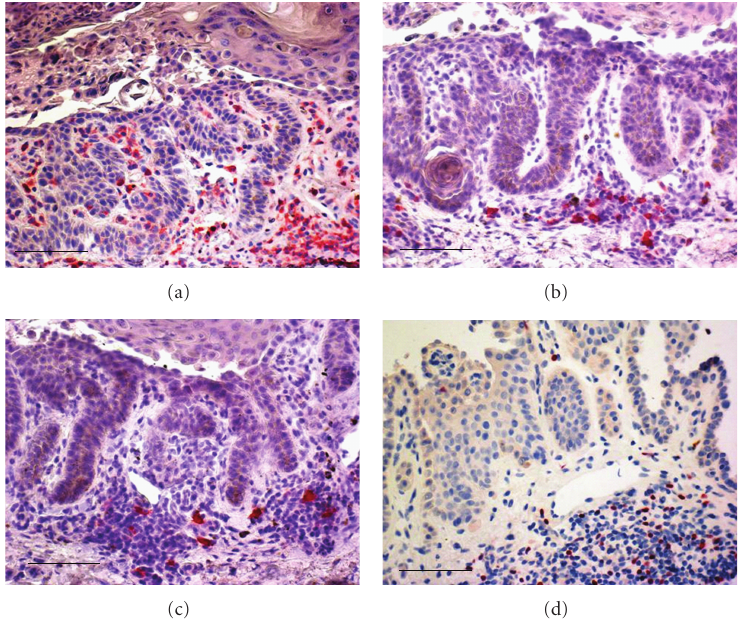
Figure 2: The inflammatory infiltrate in Darier’s disease is mostly constituted by CD4+ T lymphocytes (a), with less numerous CD8+ T (b), and a few CD20+ B (c) lymphocytes. Redstained, FOXP3+ nuclei of Tregs are shown in (d) Immunohistochemistry; original magnification, × 200; Scale bar = 75 μ m; Chromogen: